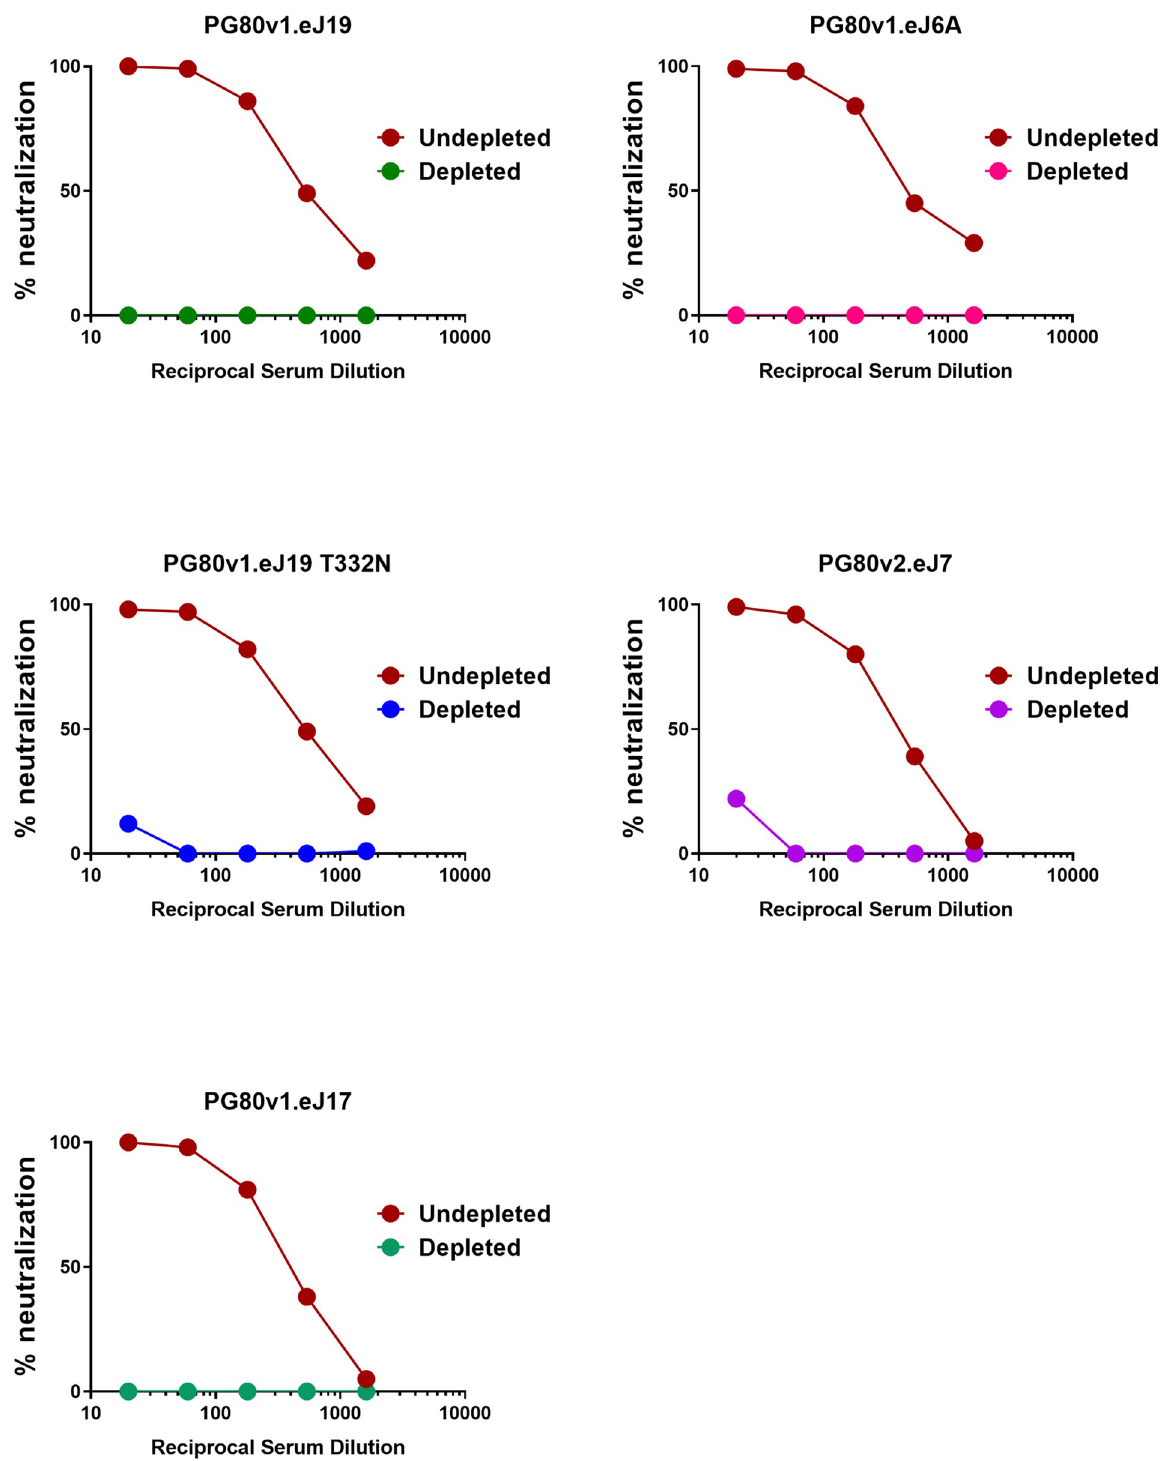
Fig 7. Effect of depletion of rabbit sera with 1PGE-THIVC SOSIP trimer on neutralization of pseudoviruses expressing sequence matched and unmatched autologous envs . Serum samples obtained at week 22 from best responder (rabbit#1) was depleted by incubating with purified magnetic beads coated with 1PGE-THVC trimeric Env. The depleted and undepleted serum was assessed for its ability to neutralize pseudoviruses expressing autologous envs by TZM-bl luciferase assay.